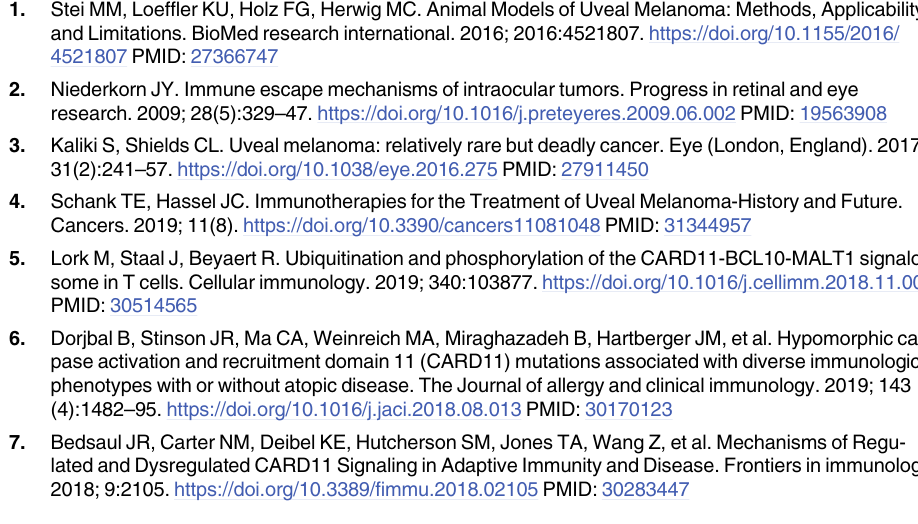
S1 Table. DEGs between high and low CARD11 expression groups. S2 Table. Univariate Cox analysis of 860 DEGs. S3 Table. Differentially expressed miRNA between high and low CARD11 expression groups. S4 Table. Differentially expressed lncRNA between high and low CARD11 expression